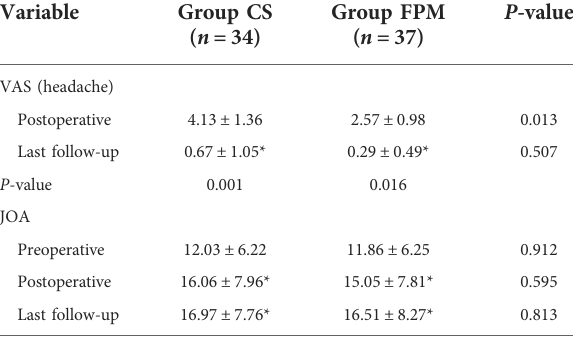
TABLE 4 Clinical outcomes in group CS and group